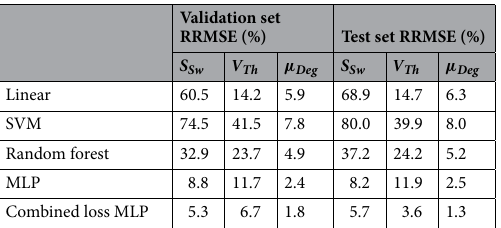
Table 2. Performance comparison of the proposed combined loss MLP model with other machine learning models for secondary property predictions. The RRMSE metric is used for the evaluation.